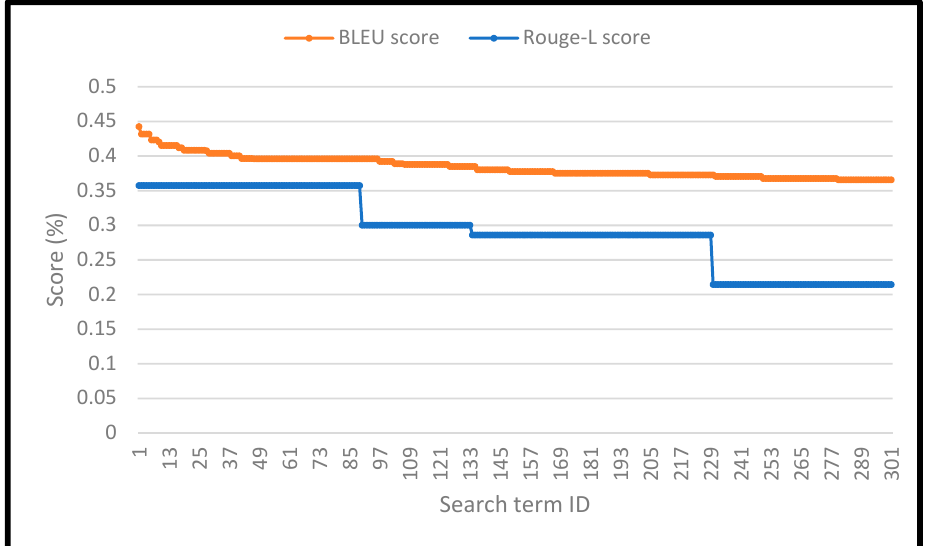
Figure 7. BLEU and Rouge-L scores for the search results. The figure shows the scores of the long search queries. The average BLEU score for the long search queries (on the horizontal axis) reached 38.3%, and the average Rouge-L score was